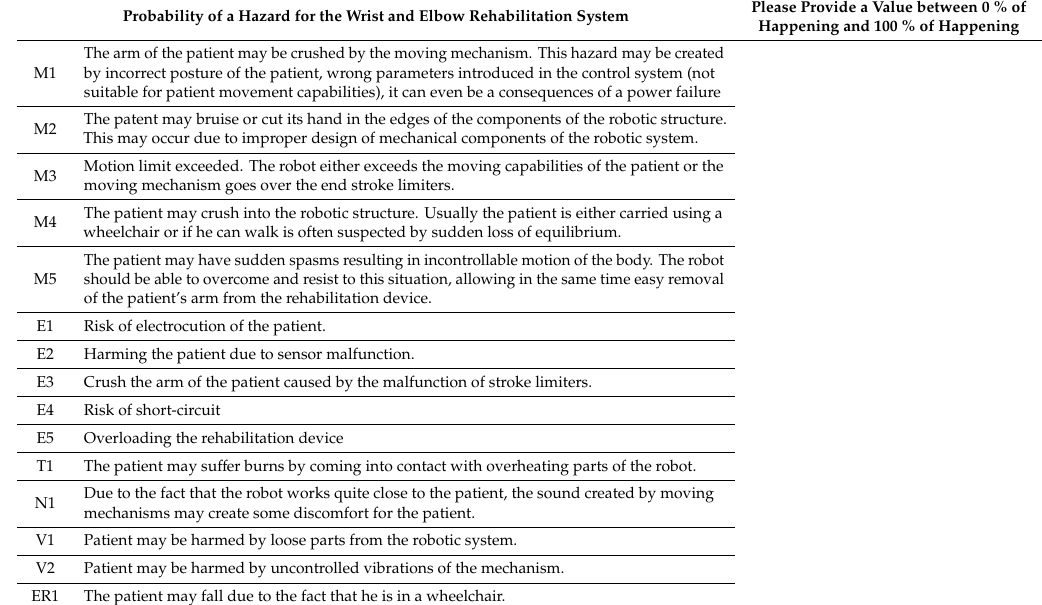
Table A1. How often would you consider the occurrence probability of the following hazards? (Please provide a numeric value in the interval